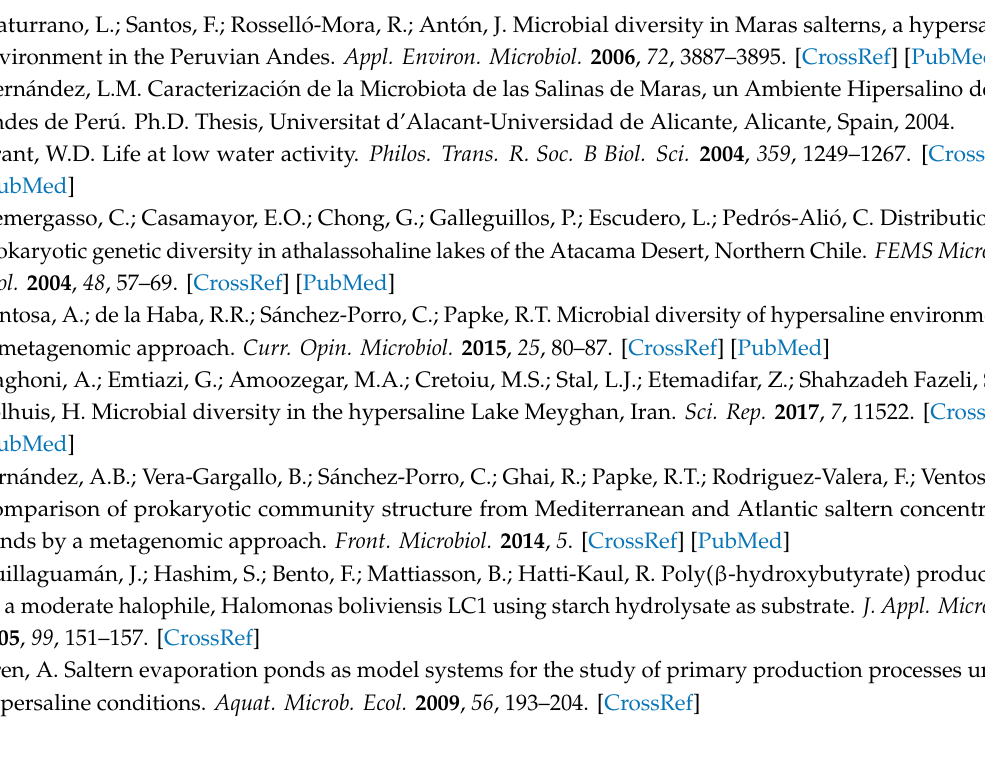
Figure S1: Rarefaction curves based at level species diversity, Figure S2: Dendrogram of all samples. Analysis of beta-diversity was carried out at species level using hclust and Bray-Curtis dissimilarity, Figure S3: Pangenome of draft genome (a) Halomonas elongata (b) Idiomarina loihienis , Figure S4: Protein-sharing viral network of virus from samples of Acos, Table S1: Indexes of